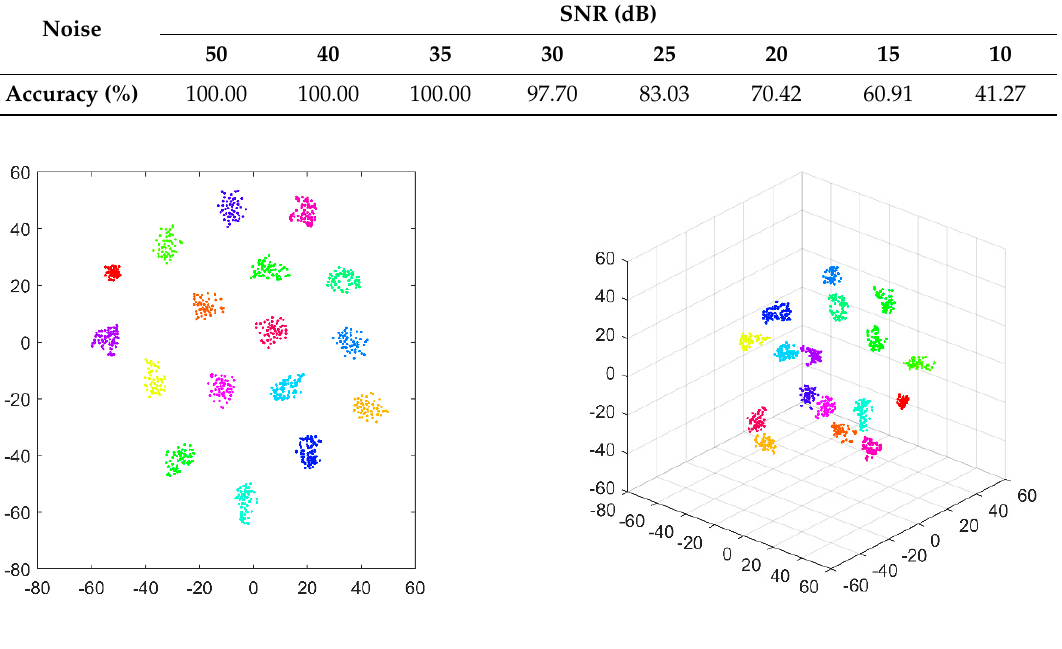
Table 1. Accuracy of damage identification using the transmissibility function